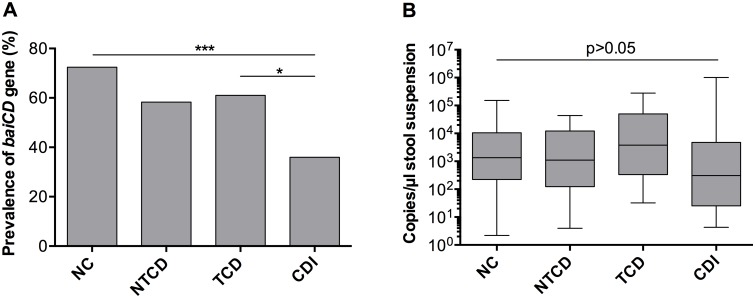
BaiCD gene cluster prevalence/abundance and C. difficile state.The prevalence/abundance of the baiCD gene cluster was analyzed in fecal samples of patients with C. difficile infection (CDI, n = 64), colonization with non-toxigenic C. difficile (NTCD, n = 12), toxigenic C. difficile (TCD, n = 21), and of C. difficile-negative (NC, n = 138) patients by species-specific qPCR. Fig 1A: End-point qPCR revealed a significantly higher prevalence of baiCD genes in NC and TCD than in CDI samples (*** p<0.0001, * p<0.05, chi-square test and Fisher´s exact test). Fig 1B: BaiCD gene cluster copy numbers were not statistically different in baiCD-positive NC (n = 96), NTCD (n = 6), TCD (n = 12) and CDI (n = 21) samples (box-and-whiskers plot, median-IQR-min/max, one-way ANOVA, p = n.s. (non-significant)).